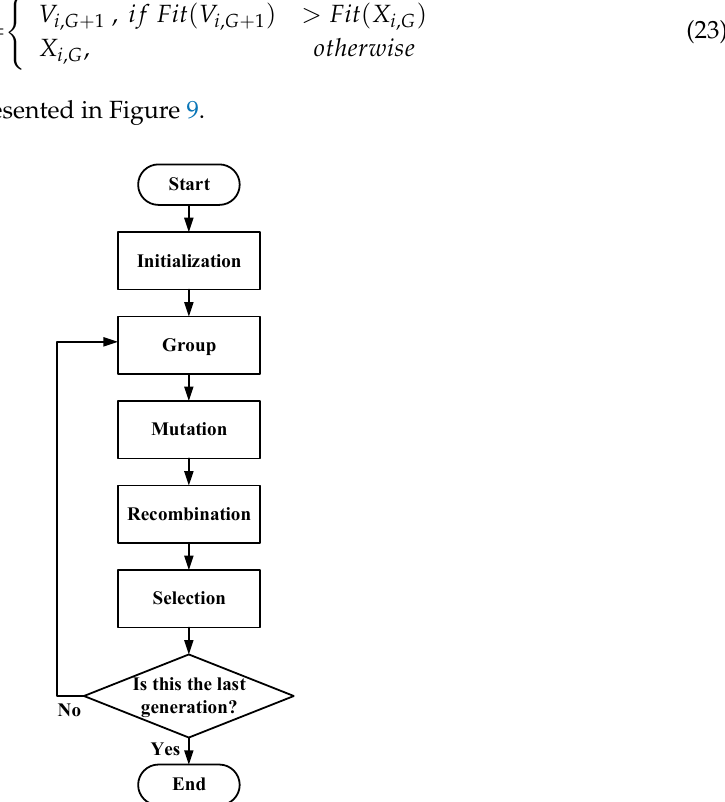
Figure 9. Flowchart of the proposed dynamic group differential evolution